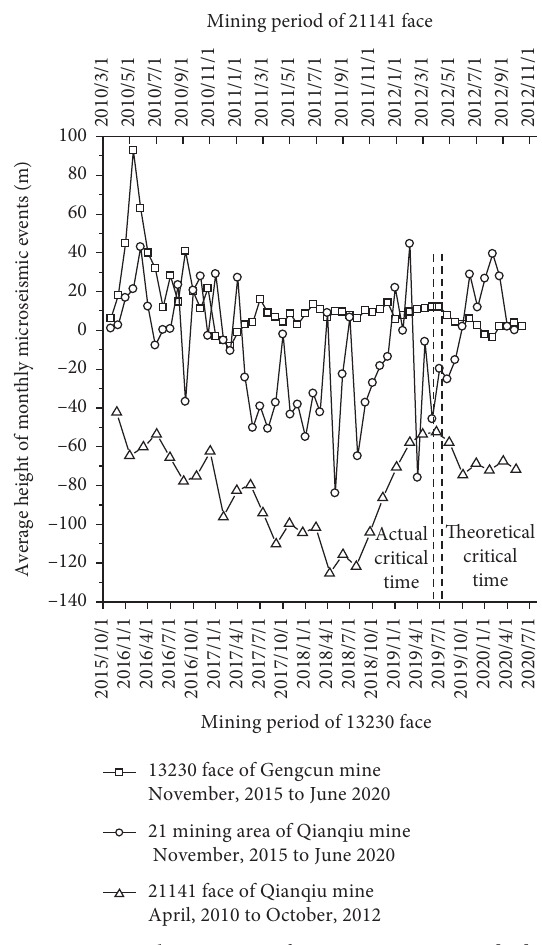
Figure 9: Height variation of microseismic events.